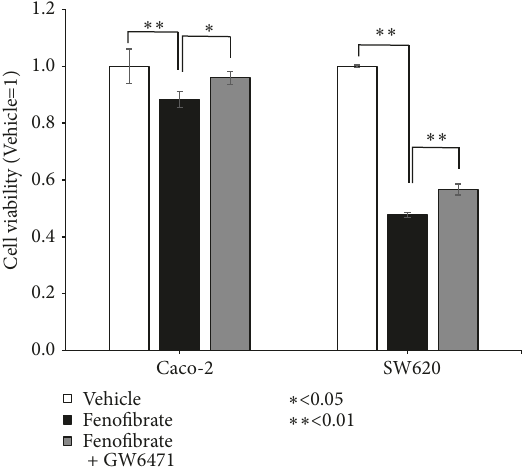
Figure 3: PPAR- 𝛼 activation affects cell proliferation. Human colorectal carcinoma cells (Caco-2 and SW620) were treated with fenofibrate (200 𝜇 M for Caco-2 cells and 100 𝜇 M for SW620 cells) and 3 𝜇 M of GW6471 for 48h, and cell proliferation was determined by an MTT assay. Error bars indicate standard deviation.